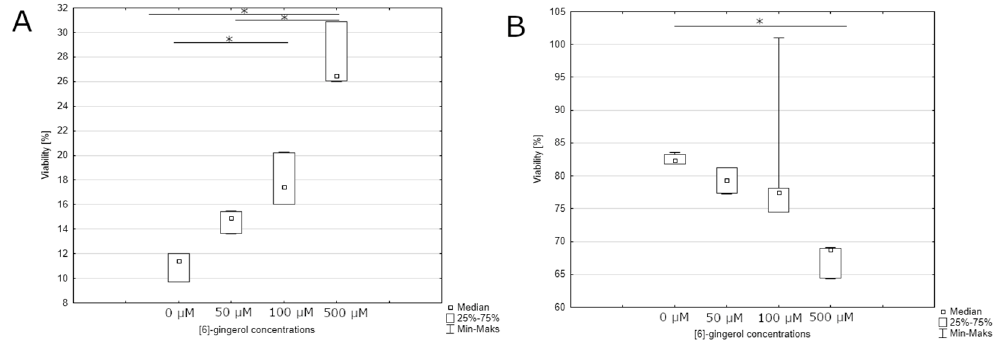
Figure 8. ( A ) assessment of the percentage of late stage of apoptotic or dead cells after 24 h incubation depending on the concentration of [6]-gingerol. The representative experiment is a median and a di ff erence between [6]-gingerol concentration and the control evaluated using ANOVA Friedman p = 0.00044 and post-hoc tests * p < 0.05; ( B ) e ff ect of increasing [6]-gingerol concentration on U-118MG